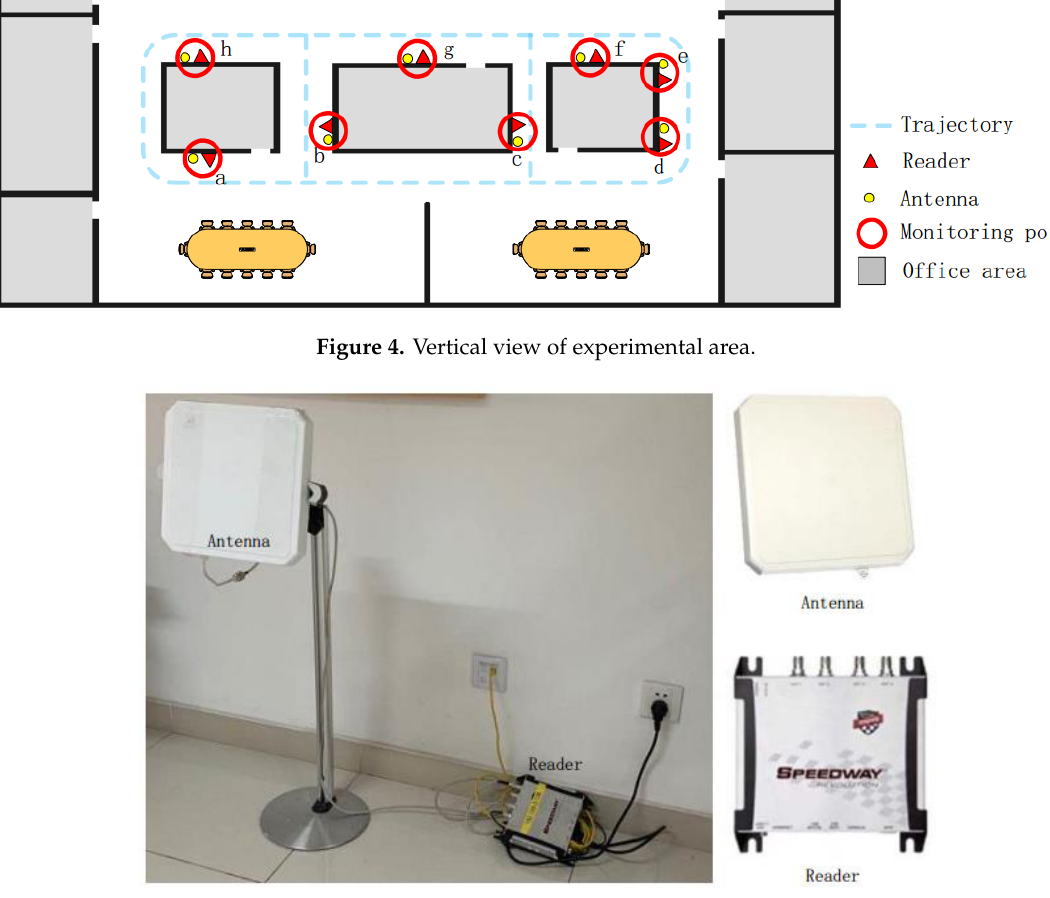
Table 2. Data set introduction.